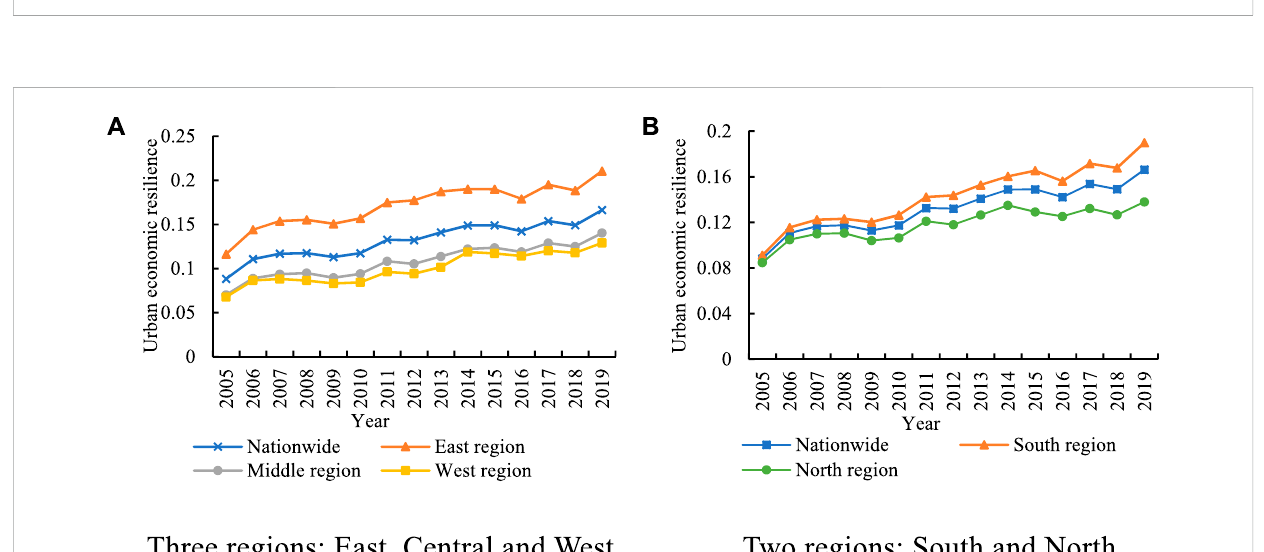
FIGURE 1 Study area of this paper. (A) Three regions: East, Central, and West. (B) Two regions: South and North.